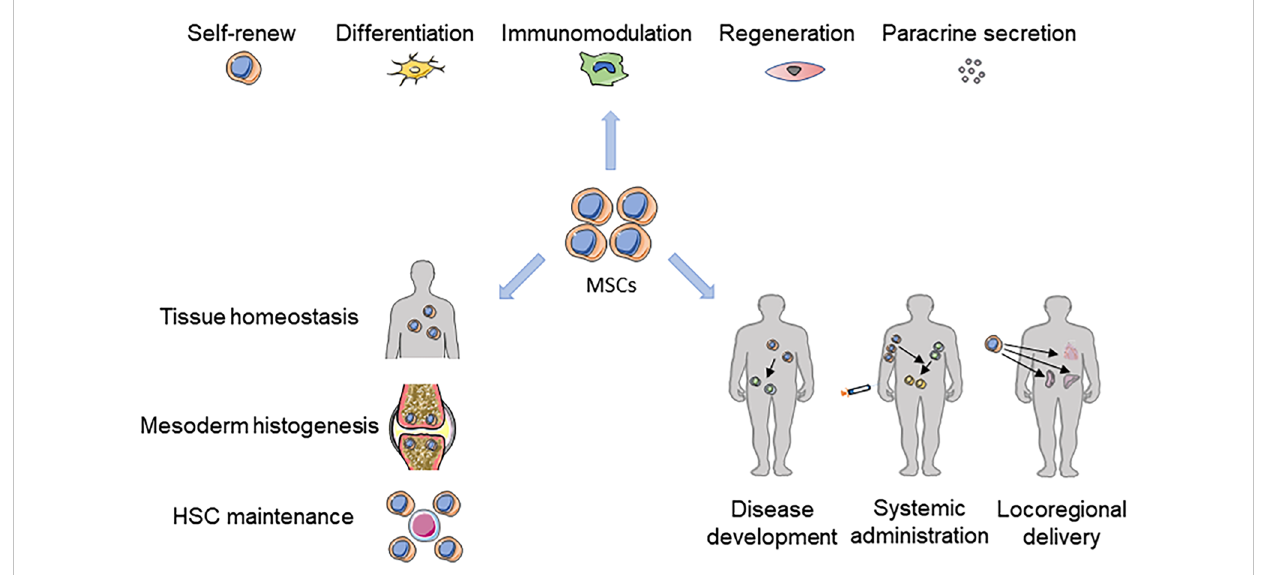
FIGURE 1 The MSC landscape in tissue homeostasis, disease and therapies. The powerful self-renewal and differentiation capabilities, immunomodulatory capacity, regeneration-promoting functions, and paracrine effects of MSCs all play important roles in tissue homeostasis, mesodermal histogenesis, and maintenance of HSC function. MSCs can intervene in disease development and treat related diseases through systemic or local